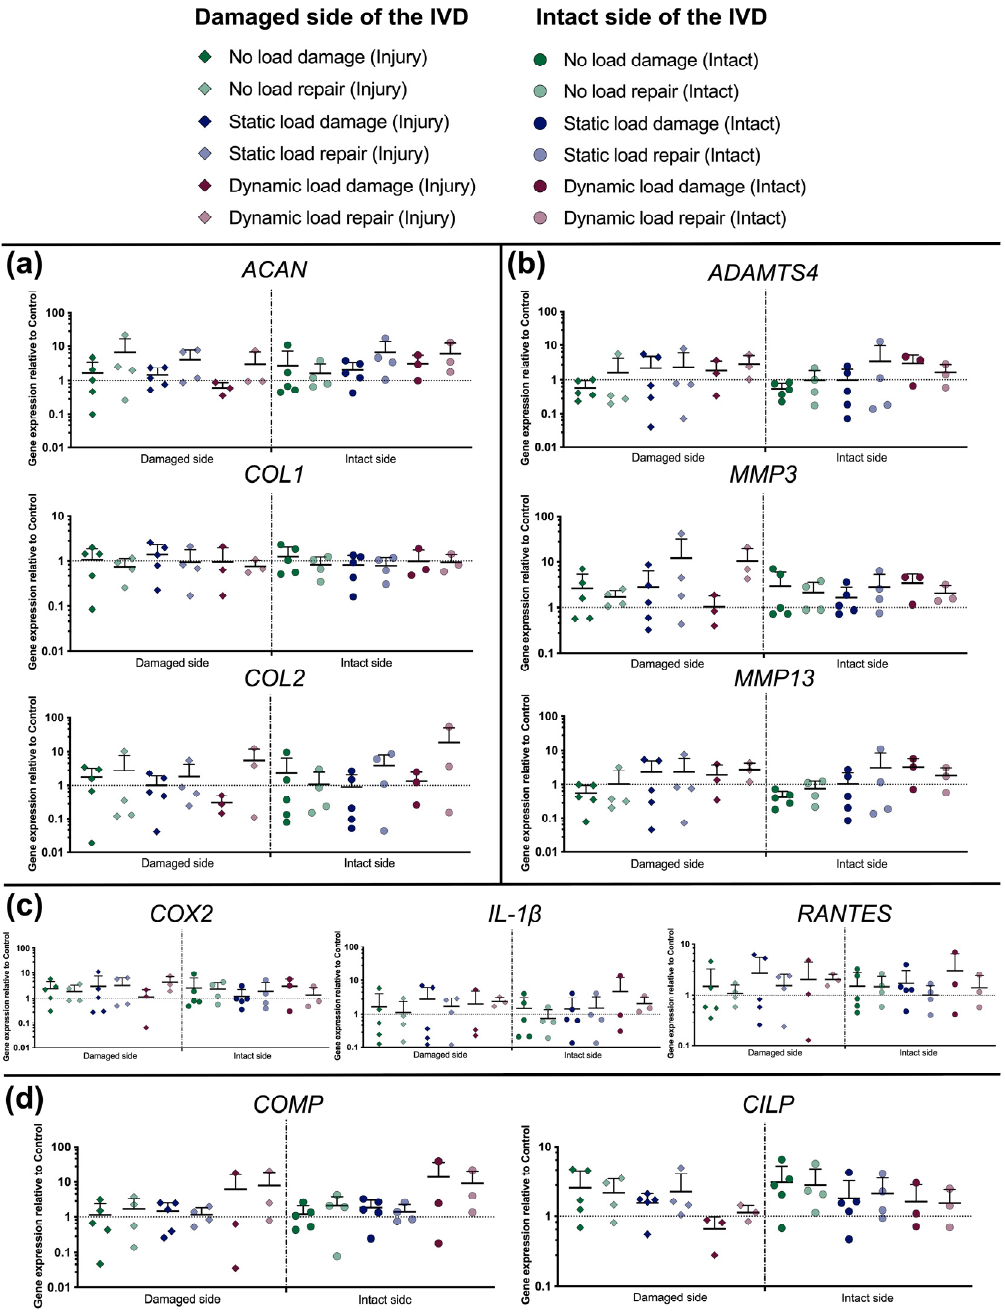
Figure 7. Relative gene expression of: ( a ) anabolic genes related to the ECM production of the IVD, including ACAN , COL1 , and COL2 ; ( b ) catabolic genes, including ADAMTS4 , MMP3 , and MMP13 ; ( c ) inflammatory genes, including COX2 , IL-1 β , and RANTES ; and ( d ) mechanosensitive genes, including COMP and CILP . Mean + SD, n = 3–5.